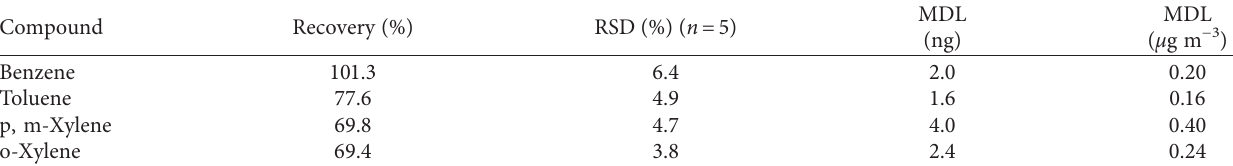
Table 2: Method evaluation of